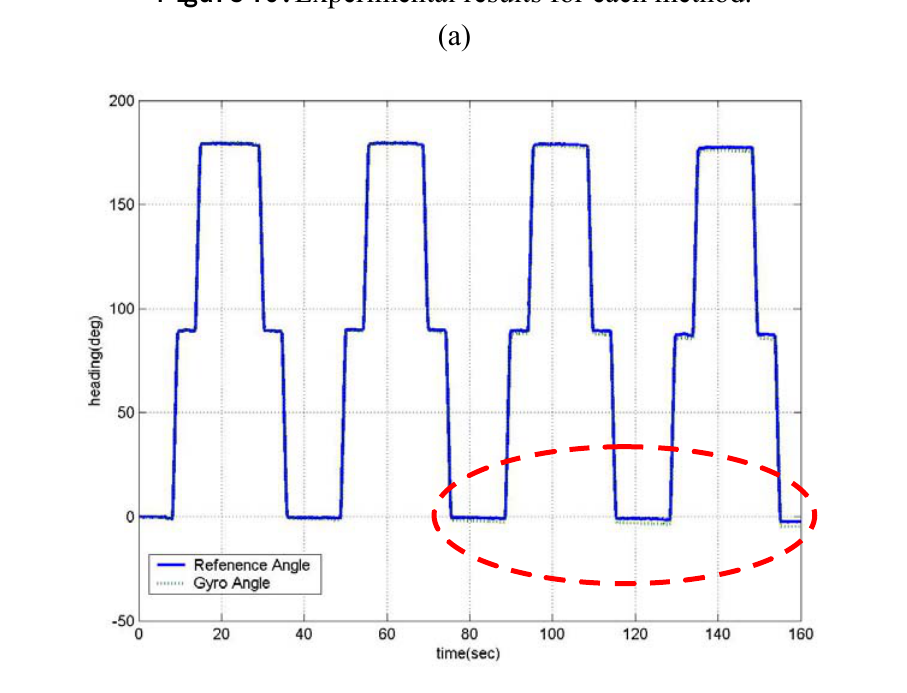
Figure 10. Experimental results for each